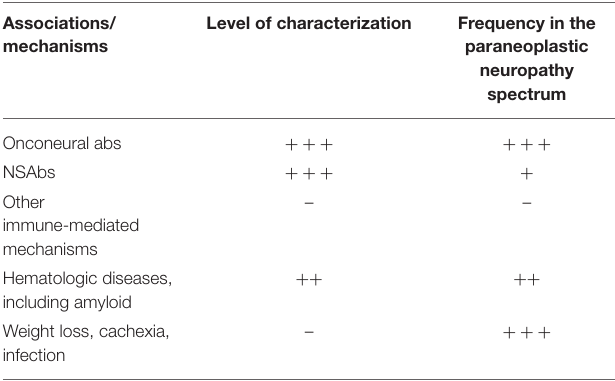
TABLE 1 | Level of characterization and frequency of mechanisms underlying paraneoplastic neuropathies. Associations/